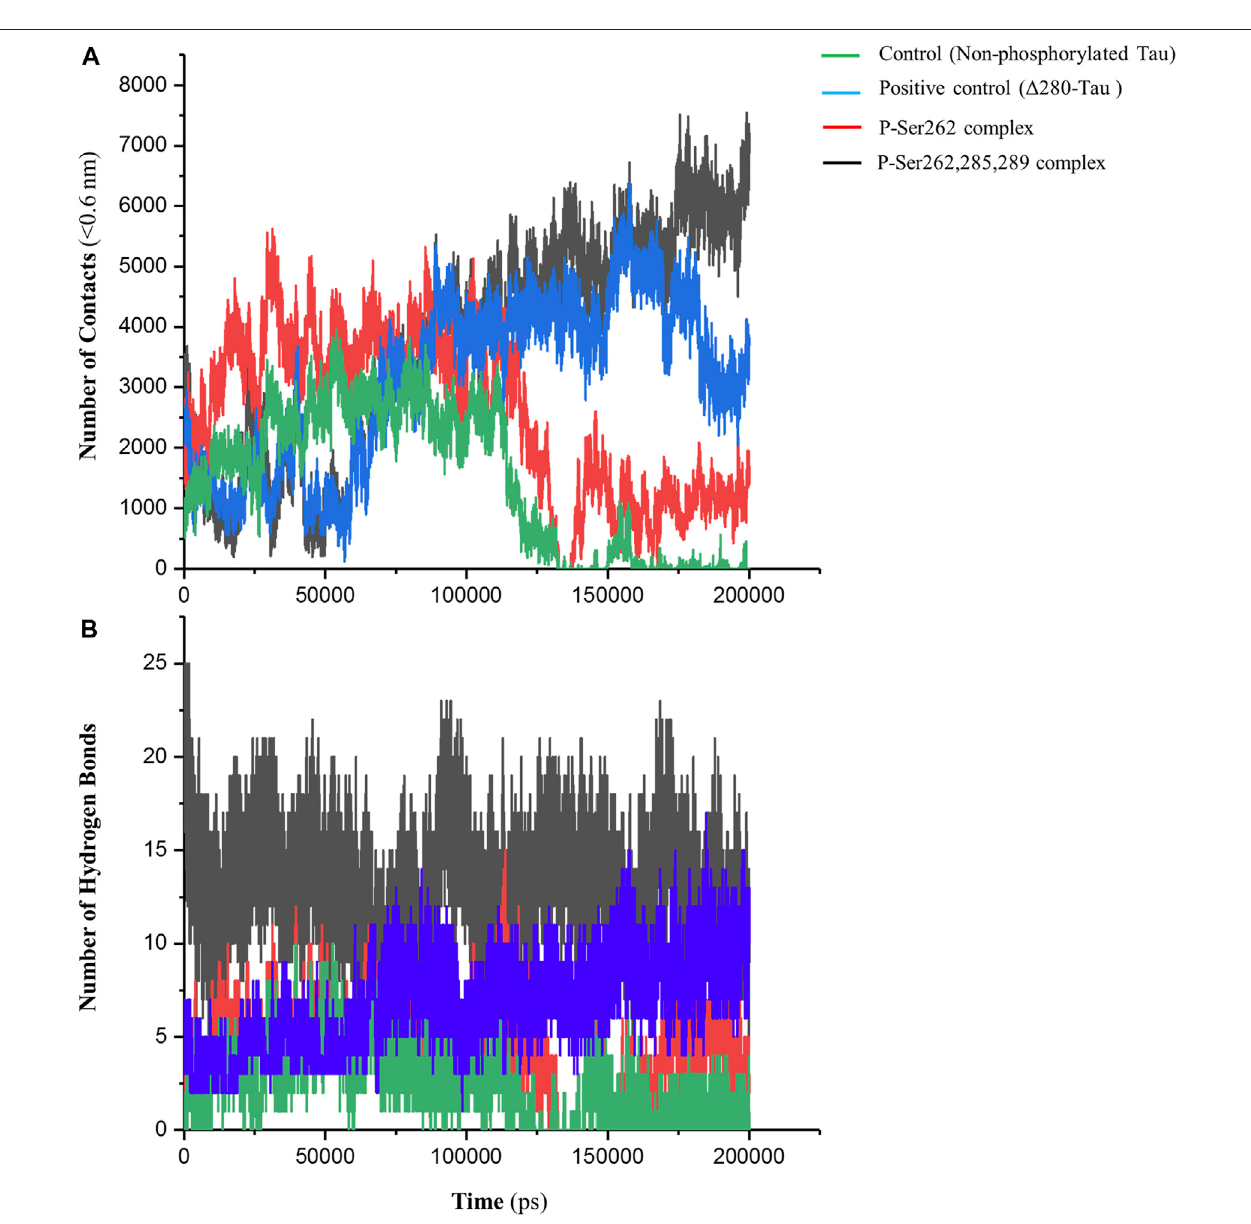
FIGURE 2 | Number of contacts (NC) and number of hydrogen bonds (NHB) between two segments in the control (non-phosphorylated tau), positive control ( Δ 280-tau), and the complexes with one (P-Ser262) and three (P-Ser262, 285, and 289) phosphorylated sites during 200 ns simulations. (A) NC was calculated at a distance of less than 0.6 nm, which decreased in the P-Ser262 compared to P-Ser262, 285, and 289. (B) NHB in P-Ser262 is less than in P-Ser262, 285, and 289.